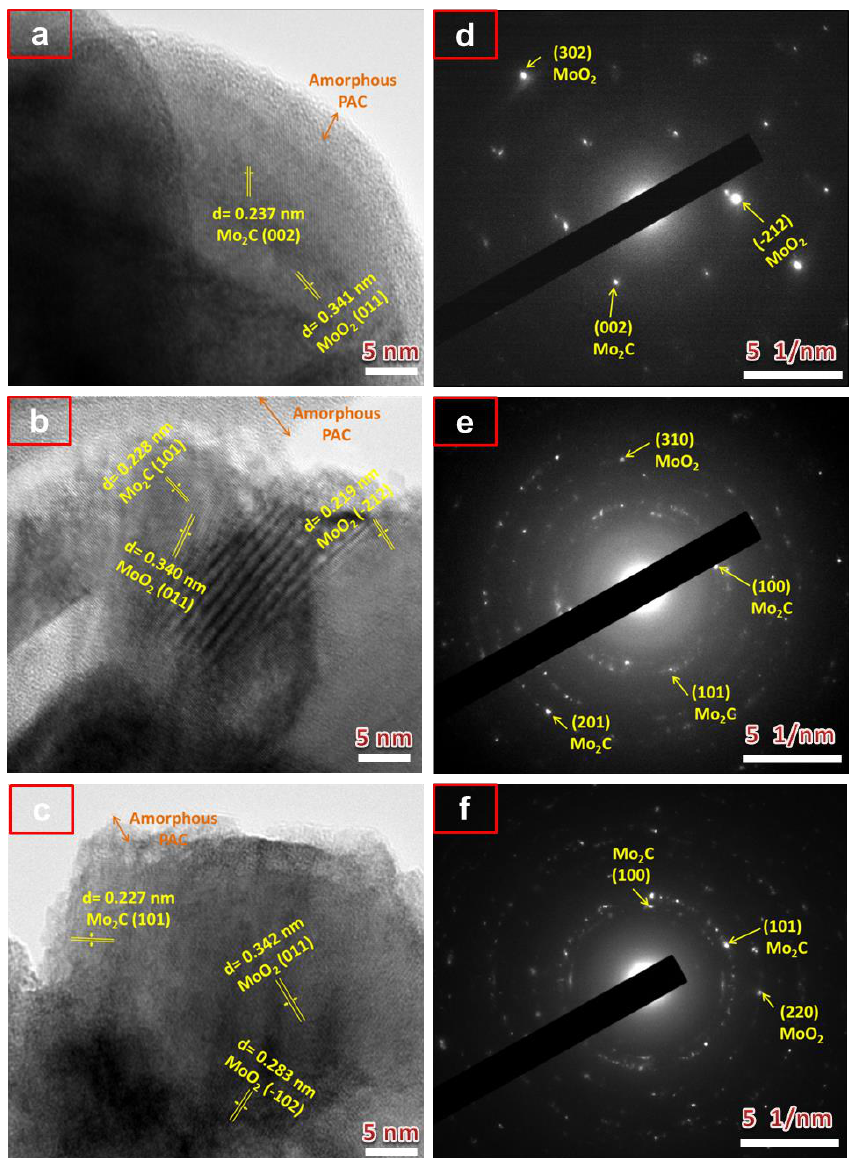
Figure 3. HRTEM micrographs and SAED patterns of ( a , d ) PAC/MoO 2 /Mo 2 C-0.5, ( b , e ) PAC/MoO 2 /Mo 2 C-1 and ( c , f ) PAC/MoO 2 /Mo 2 C-2 ternary composites, respectively.